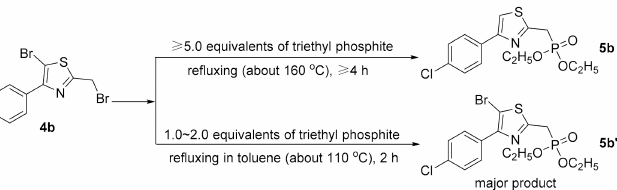
Scheme 2. Different phosphonates 5b and 5b’ depending on different reaction conditions in Arbuzov